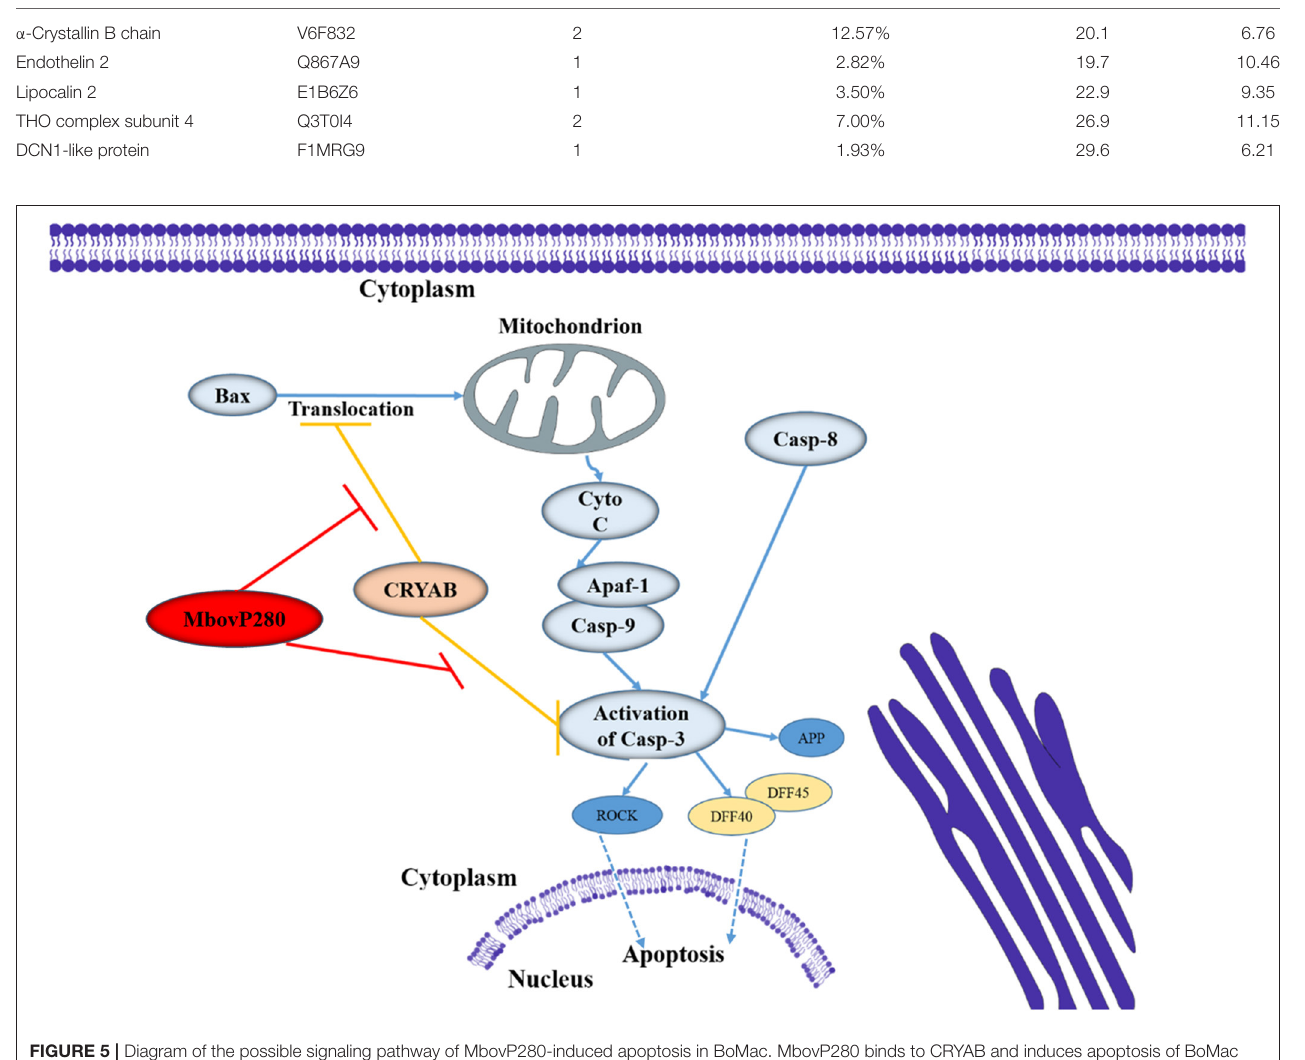
Frontiers in Immunology |